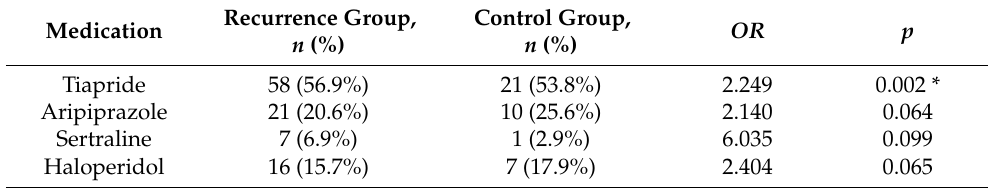
Table 6. Correlation between several types of medication and tic recurrence (modifiable factor).